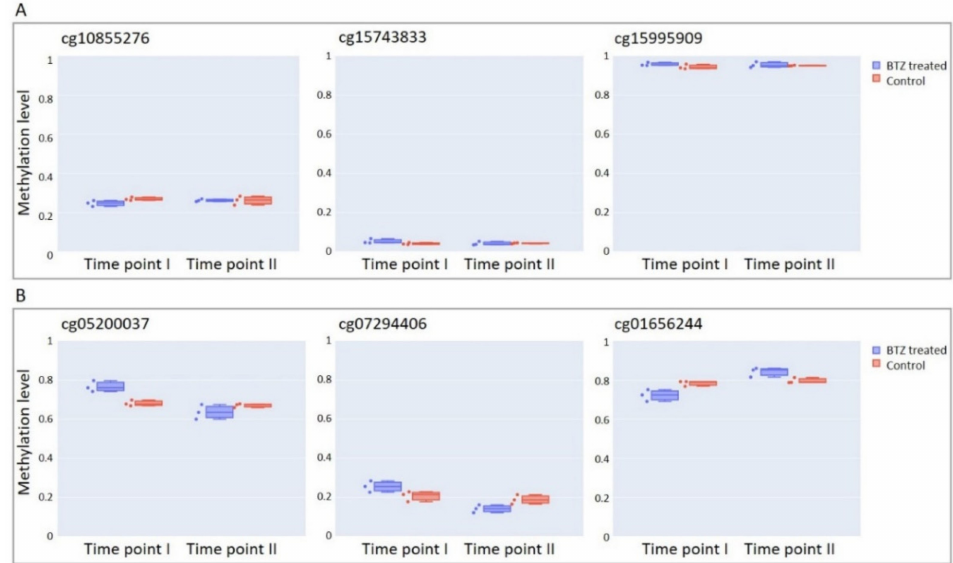
Figure 1. Examples of CpG sites with ( A ) stable and ( B ) changed methylation levels between experimental time points in both BTZ-treated cells and controls. Time point I: after the first cycle of BTZ treatment. Time point II: after the second cycle of BTZ treatment. The blue box indicates BTZ-treated and the orange box non-treated control